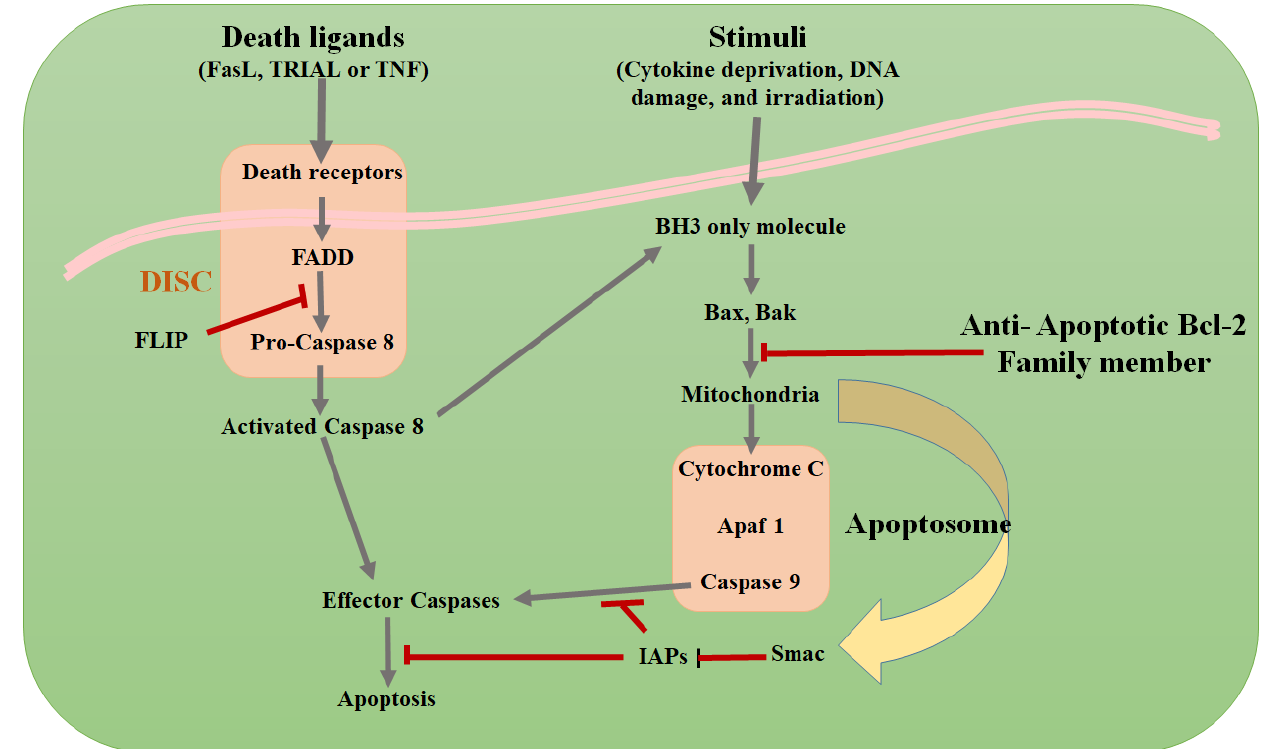
Figure 2. Overview of apoptosis signaling pathways and the effects of pro-survival signaling, immune cells and the tumor microenvironment. (Phosphatidylserine Fas ligand (FasL), cancer necrosis factor (TNF) and TNF-related apoptosis-inducing ligand (TRAIL), FAS-associated death domain protein (FADD), death-inducing signaling complex (DISC), activated caspase 8 (also called FADD-like IL-1 converting enzyme (FLICE)), FLICE-like inhibitory protein (FLIP), pro-apoptotic B-cell lymphoma-2 (Bcl-2) family members (Bax and Bak), apoptotic protease activating factor-1 (APAF-1), second mitochondria-derived activator of caspase (Smac), and inhibitor of apoptosis proteins (IAPs).